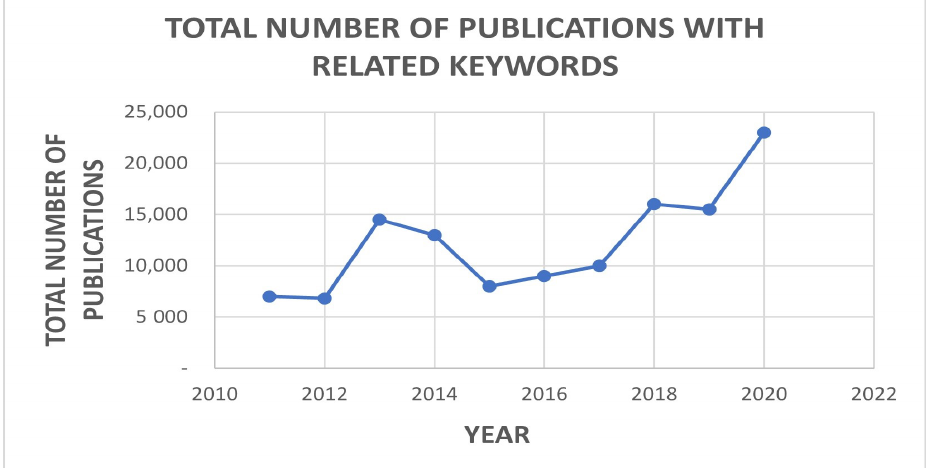
Figure 1. Number of research publications with keywords: “Machine Learning, Uncertainty Quantifi- cation”, published within the time period of